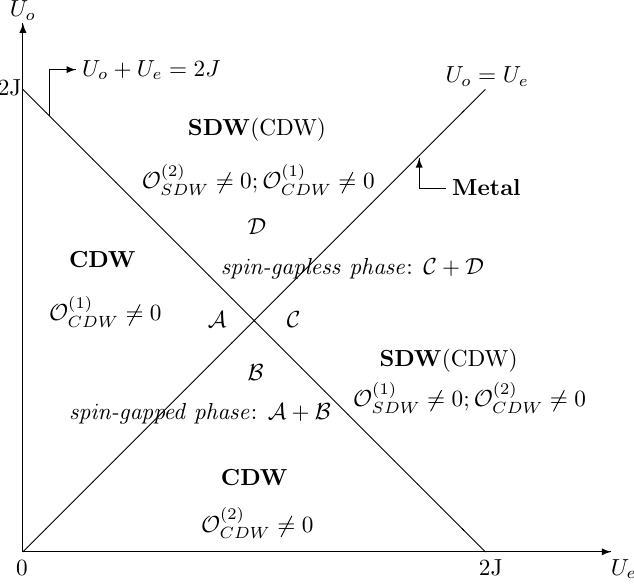
Figure 1. The weak-coupling phase diagram of 1D unusual t – U – J model with alternating on-site repulsion at quarter filling. The subleading instability is indicated in